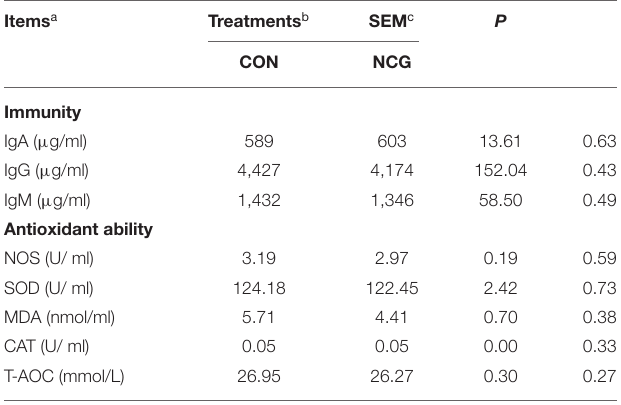
TABLE 6 | Effect of NCG on plasma index associated with altitude stress of experimental Jersey